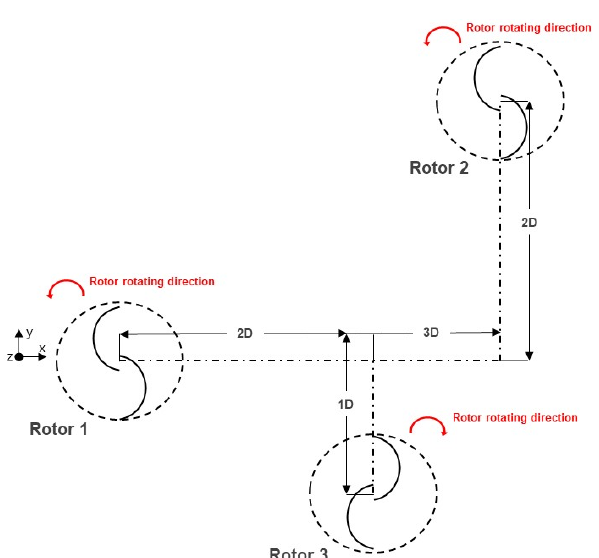
Figure 16. Velocity distribution according to rotor rotation position for three rotors in case 9. 5. Conclusions This paper presents a conceptual design and modeling method for the development of small urban wind turbines as well as a wake flow analysis of the rotor arrangement that can maximize rotor efficiency. A three ‐ dimensional CFD simulation was performed, and the analysis results were compared with the experimental data from previous studies to examine their validity. At a Reynolds number of 8.67 × 10 5 (wind speed 14 m/s), the ex ‐ perimental data and CFD analysis results showed similar efficiency (up to 24%). Because the objectives of this study were to ensure stability in unexpected situations and to de ‐ velop an eco ‐ friendly turbine using recycled fabric materials, additional devices and end ‐ plates that could improve the rotor efficiency were not applied. The OR and AR, which are the design parameters that most significantly affect rotor performance, were deter ‐ mined based on a semi ‐ circular rotor. The performance was compared when the OR was 0 and 1/6, and higher efficiency was confirmed when the OR was 1/6. Thirteen cases were generated according to the AR, and the power change was compared. Efficiency was re ‐ alized when the AR was designed to be above 2.8, and the targeted power was achieved by RotorV10, which had an AR of 4.5. The performance of the Bach and elliptical types was analyzed to determine a geometry that could improve the rotor performance. The OR and AR identified based on RotorV10 were applied, and the performance of the Bach and elliptical types according to the design parameters was analyzed. In addition, the power generated by each type of rotor was compared. The three geometries exhibited similar